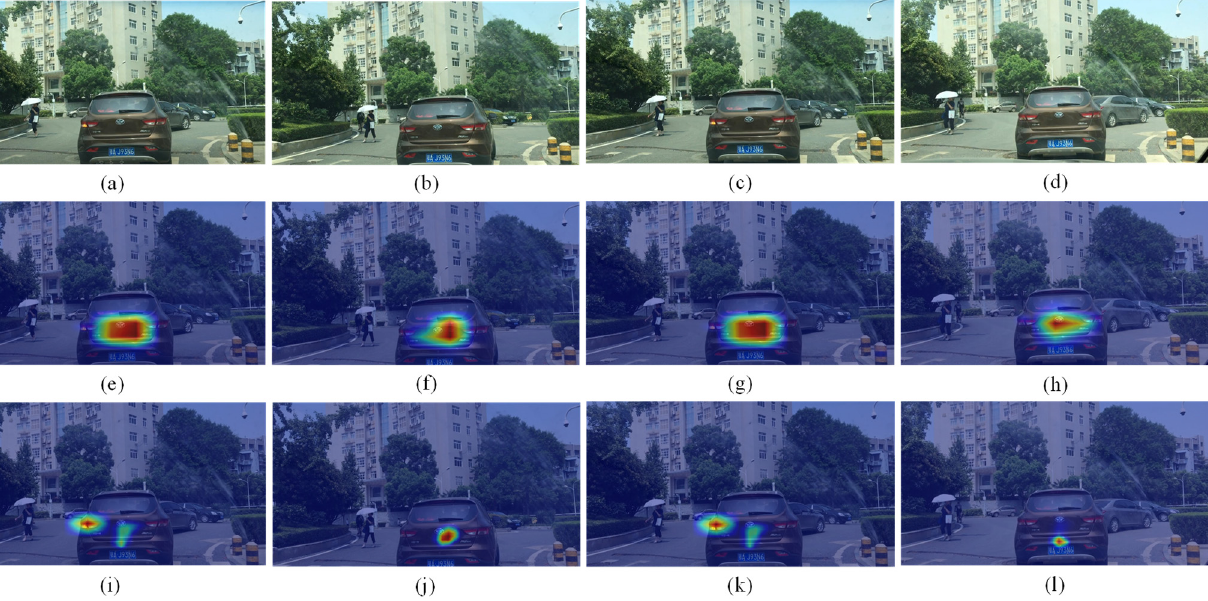
Figure 8. Detection results of the baseline and proposed method on the test set. ( a – d ) the detection results of the four test images in the baseline. ( e – h ) the detection results of the four test images in the proposed method. Figures 7a–d are four consecutive turn signal pictures, with (a) and (c) having left turn signals and (b) and (d) having no turn signals. Figure 7e–l are the interest regions of the baseline and the proposed method, respectively. We found that the baseline can only focus on the vehicle object in the images. Our proposed method can recognize the turn signal while focusing on the vehicle object, indicating that the proposed method can detect turn signals better. Figure 8a–h shows the detection results of the baseline and the pro- posed method, respectively, on the test set. Based on the discussion above, the proposed method showed better performance in detection ability than YOLOv4-tiny. This experimentally observed excellent performance